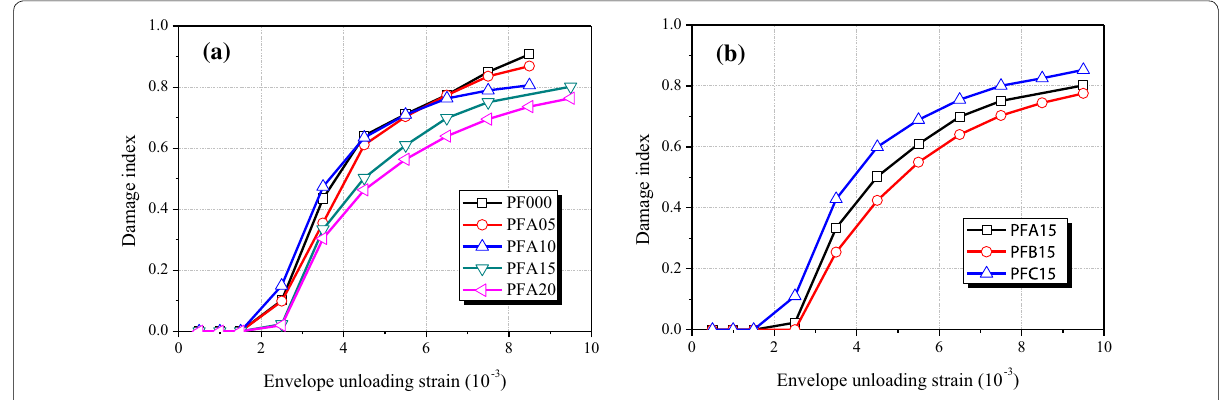
Fig. 13 Damage evolution of concrete. a Effect of fiber volume fraction. b Effect of fiber aspect ratio.